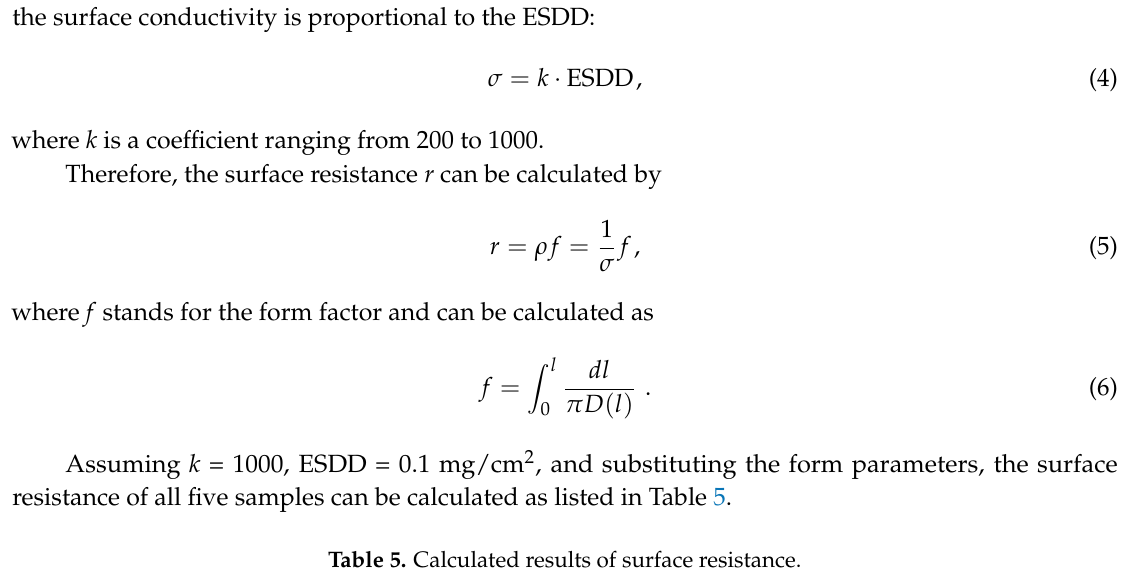
Table 5. Calculated results of surface